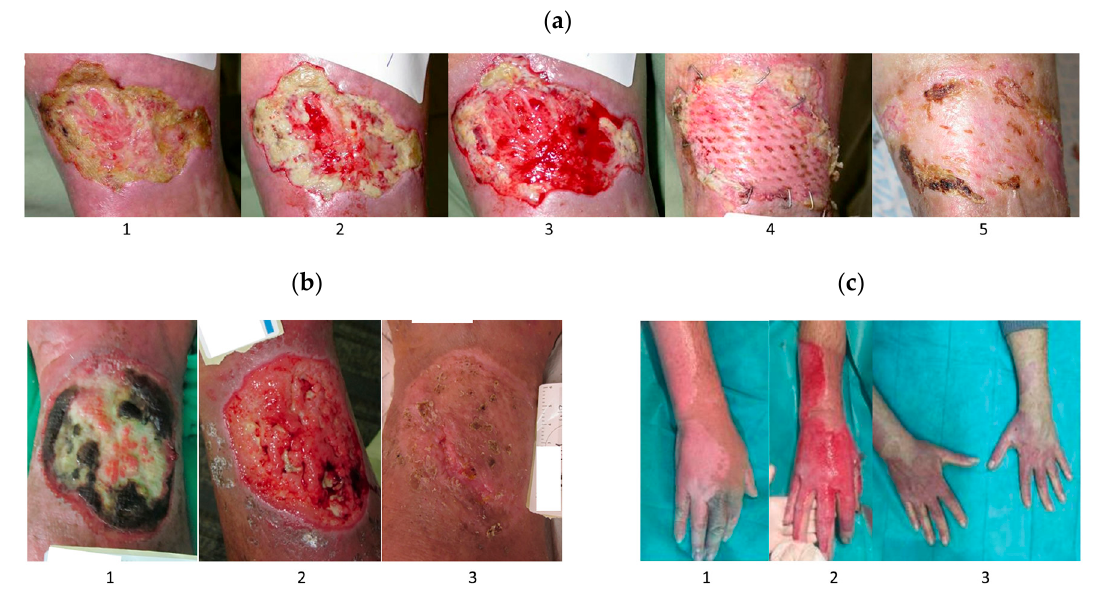
Figure 7. Bromelain-based treatment (BBT): ( a ) venous insufficiency ulcer; 1—pre-existing for 5 months, 2—after first BBT 4-h application, 3—after fourth BBT 4-h application (16 h total exposure to bromelain-based debridement), 4—one week post-split-thickness skin grafting, 5—seven weeks post-split-thickness skin grafting (Adapted with permission from [108], John Wiley and Sons, Hoboken, NJ, USA, 2018); ( b ) large venous leg ulcers; 1—venous leg ulcer pre-existing 10 weeks, 2—after 7 BBT, and 3—two months after split-thickness skin grafting (Reproduced with permission from [107], John Wiley and Sons, Hoboken, NJ, USA, 2021); ( c ) hand burn; 1—before BBT, 2—after BBT, 3—outcome 38 days post-burn (Reproduced with permission from [104], Baoshideng Publishing Group Inc., Pleasanton, CA, USA,